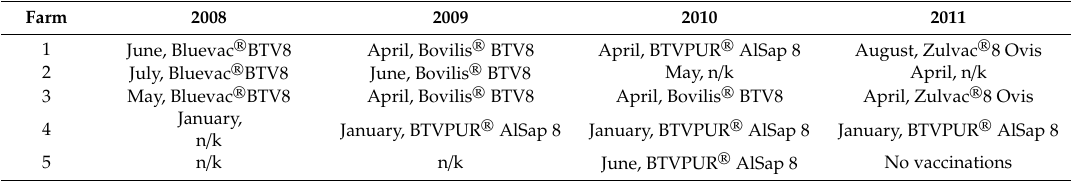
Table 2. Vaccines used in vaccinations 2008–2011. Bluevac ® BTV8 (CZ Veterinaria S.A., Porrino, Spain); Bovilis ® BTV8 (Intervet International BV, Boxmeer, the Netherlands), BTVPUR ® AlSap 8 (Merial S.A.S., Lyon, France); Zulvac ® 8 Ovis (Fort Dodge Animal Health, Naarden, the Netherlands); n / k = vaccine not